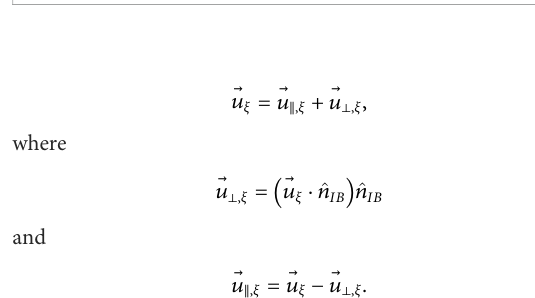
FIGURE 5 Schematicrepresentation showing thedistancesused inface